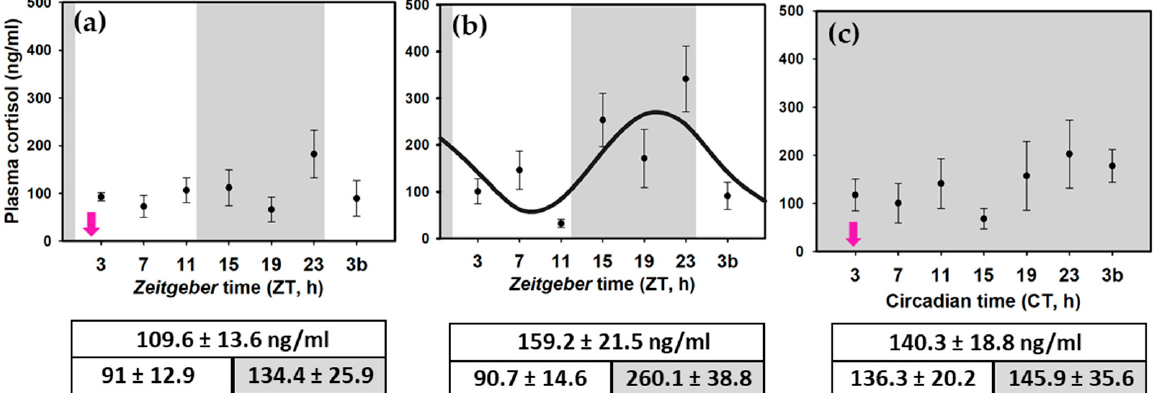
Figure 8. Daily profiles of plasma cortisol in LD-SF2 ( a ), LD-RF ( b ), and DD-SF2 ( c ) goldfish. Data are expressed as mean ± standard error ( n = 8). Grey areas indicate the darkness period, and arrows point to the feeding time when it was scheduled (ZT 2 or CT 2). The two-way ANOVA was significant, showing differences among sampling points ( p < 0.05) but not an interaction between sampling points and experimental group ( p = 0.056). The post-hoc test indicated significant differences between ZT 23 (or CT 23 in the DD group) and ZT(CT) 11, and between ZT(CT) 23 and ZT(CT) 7. The curve ( b ) shows the sinusoidal periodic function obtained by cosinor analysis when it was significant (noise/signal < 0.3). The tables below the figures show the cortisol (ng/mL) (mean ± SEM) through the 24 h cycle, during the photophase and the scotophase (lower panel; subjective day and subjective night in 4c) in each experimental group.